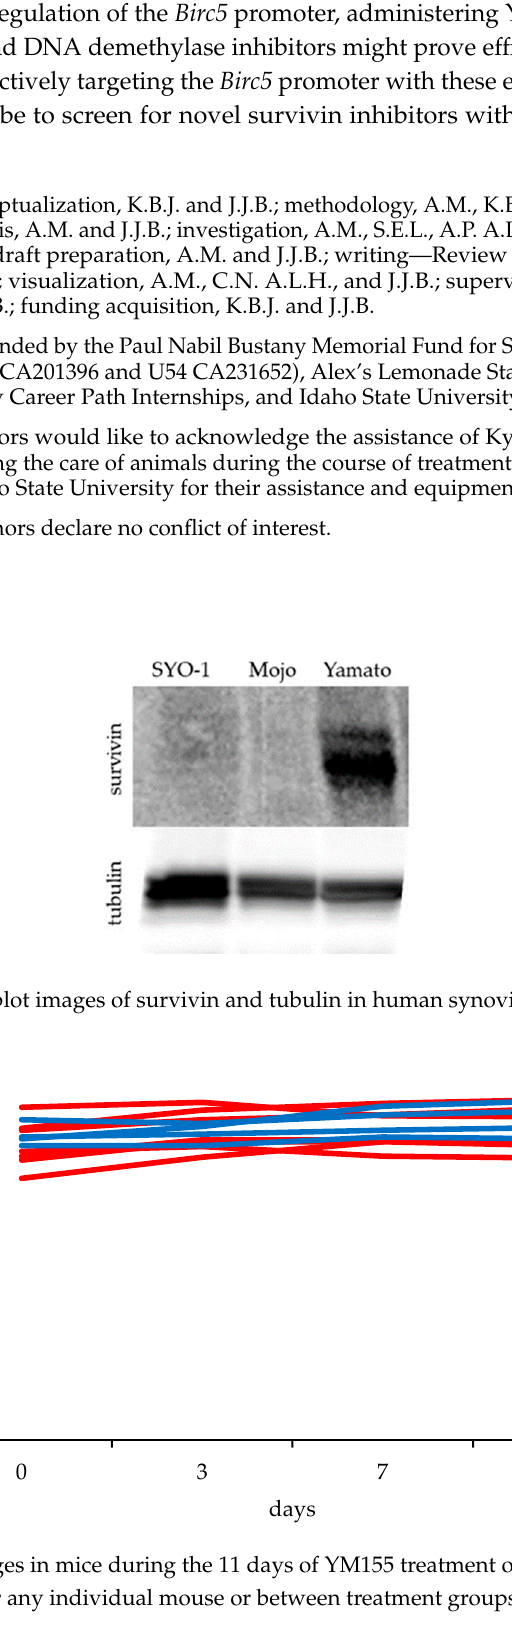
Figure A3. Epigenetic histone marks differ between control and YM155 treated human synovial sarcoma cells, HS-SY-II, at the BIRC5 promoter. ChIP-qPCR for H3K27me3 shows elevated levels at the BIRC5 promoter in the YM155 treated samples compared to controls. ChIP-qPCR for H3K27ac shows elevated levels at the BIRC5 promoter in the YM155 treated samples compared to controls. ChIP-qPCR for H3K4me1 shows a decrease at the BIRC5 promoter in the YM155 treated samples compared to controls. References 1.